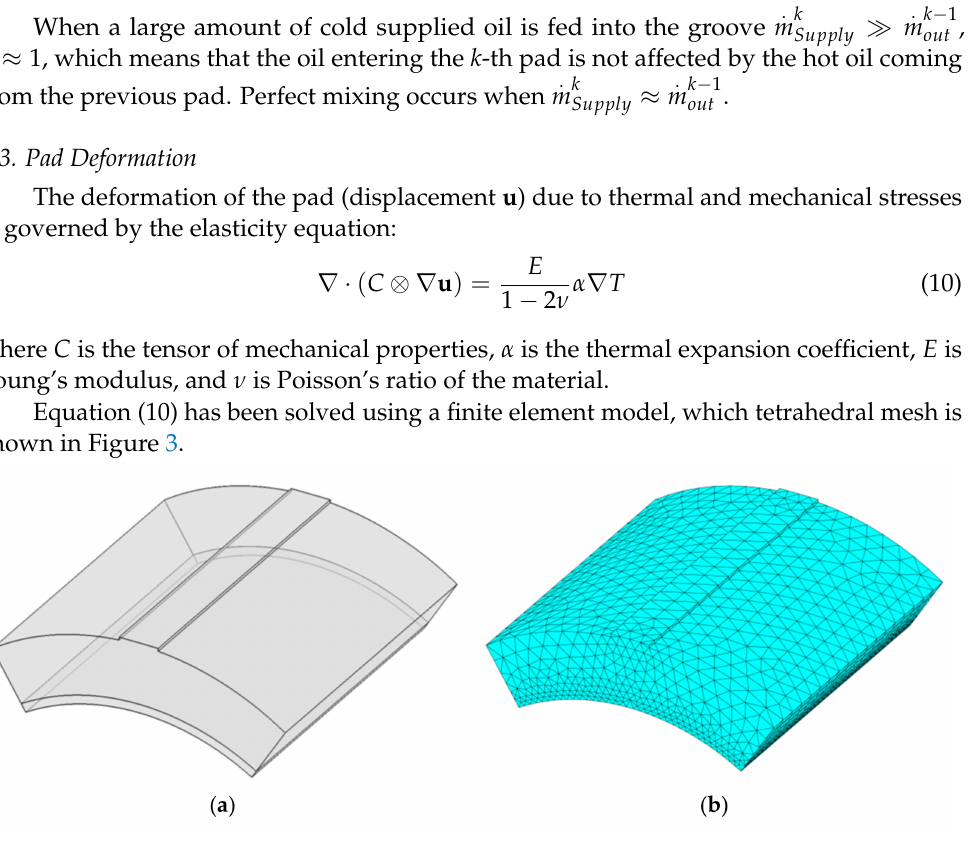
Figure 3. ( a ) Pad solid model and ( b ) mesh. As boundary conditions, a null displacement has been assumed for the surface of the pad corresponding to the pivot part. The pressure and the shear fields obtained from the Reynolds equation have been applied to the active surface of the